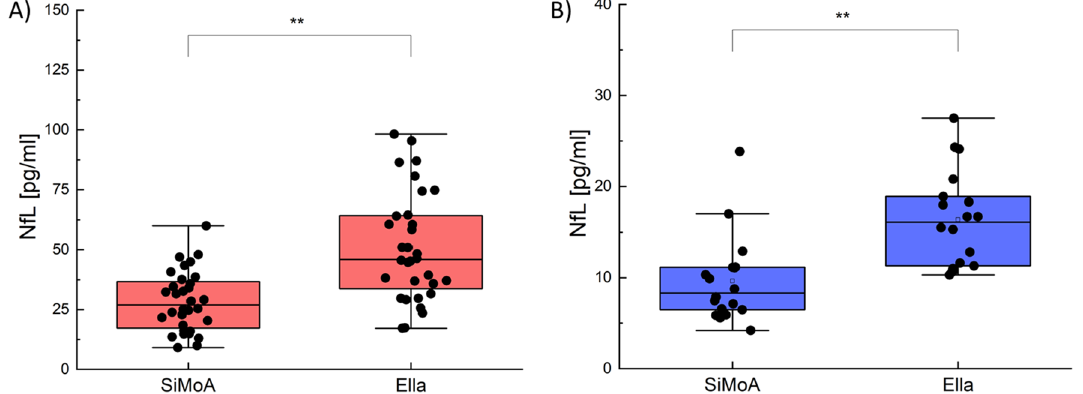
Figure 1. ( A ) Plasma levels of NfL measured by SiMoA and Ella in patients with dementia (AD plus FTD). ( B ) Plasma levels of NfL measured by SiMoA and Ella in HC. Each data point represents an individual subject analysed. Each box represents the area between the 25th and 75th percentiles [interquartile range, IQR]. Lines inside the boxes represent the median values. White dots represent the mean value for each class. Whiskers extend to the lowest and highest values within 1.5 times the IQR from the box.